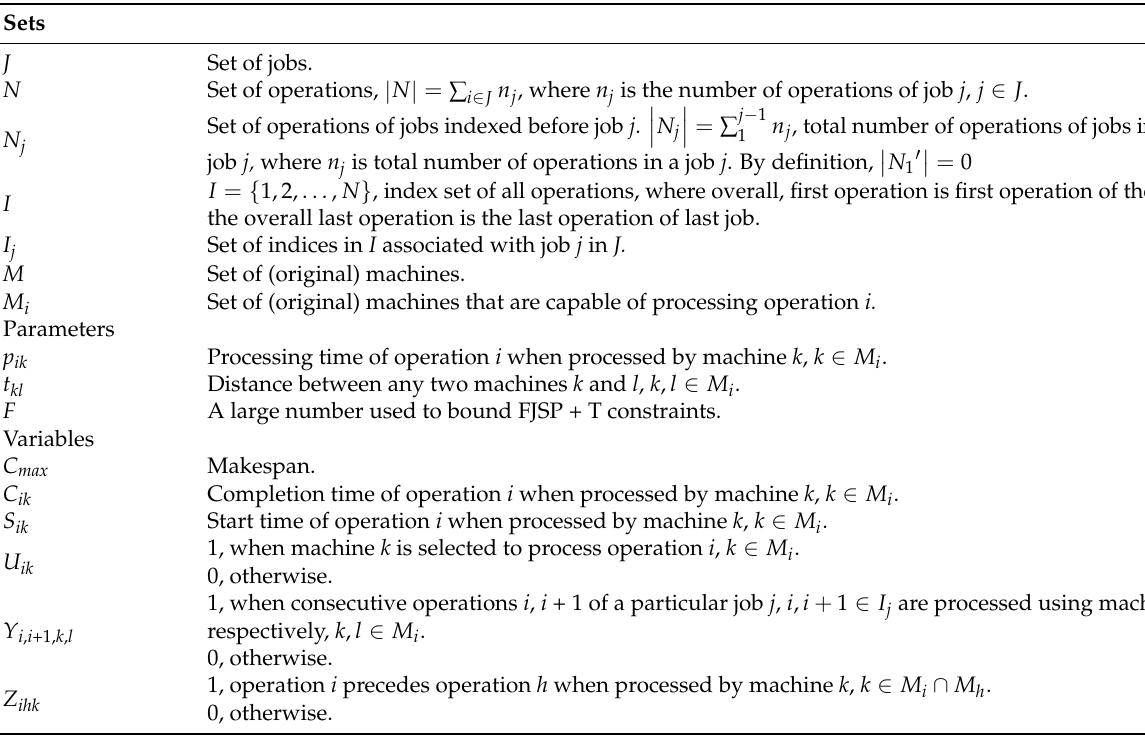
Table 1. Notation used by FJSP +